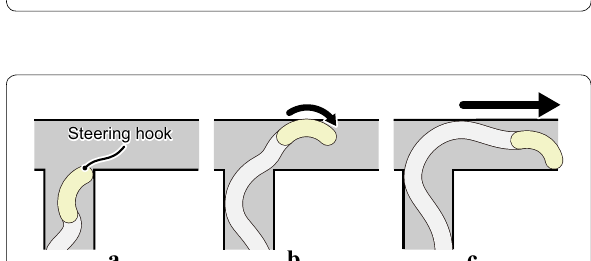
Fig. 7 Strategy for right-hand turns at Type A branch. a Device approaches the end of the pipe, keeping the tip of the device turned to the right. b Tip of the device comes into contact with the end of the pipe, causing it to bend rightward. c Tip enters the right branched pathway, with the device following. This strategy also enables left-hand turns with 180°